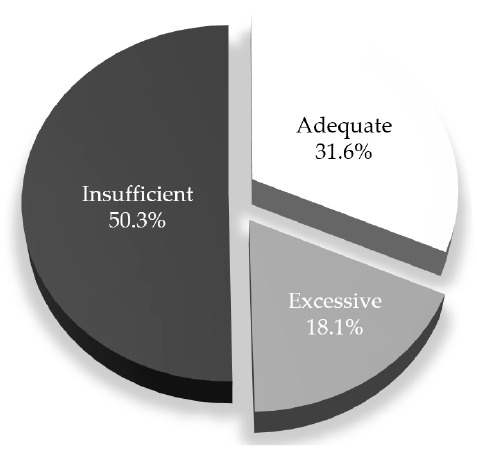
Figure 2. Distribution of gestational weight gain according to Institute of Medicine 2009.